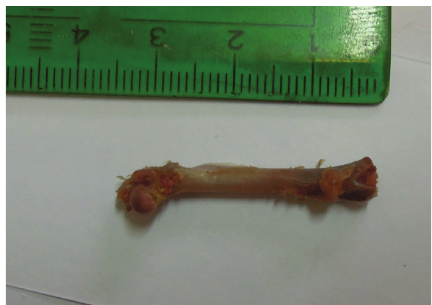
Figure 2: An example of rat’s